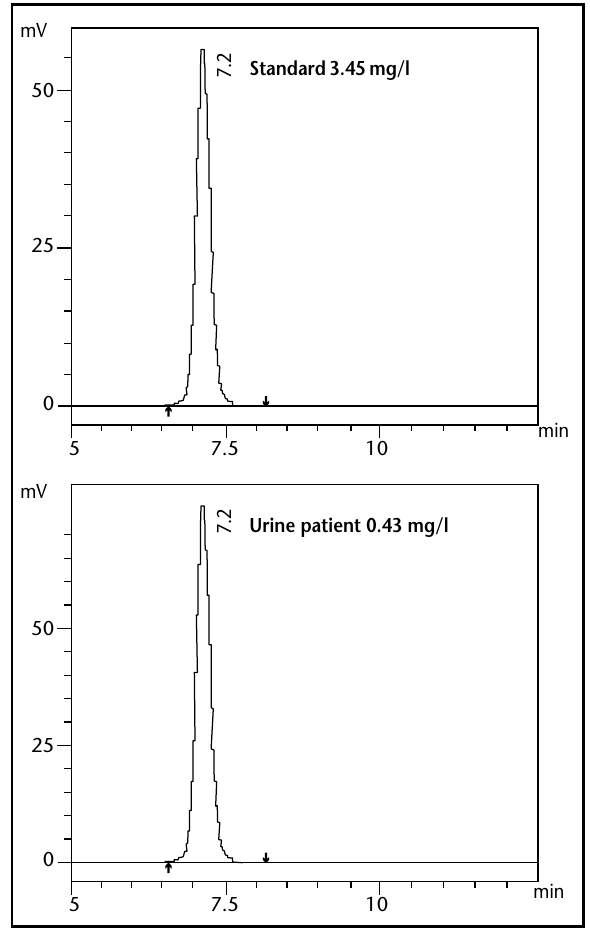
Figure – Chromatograms of δ -aminolevulinic acid in standard solution (3.45 mg/l) and urine from a patient (0.43 mg/l) eluted near 7